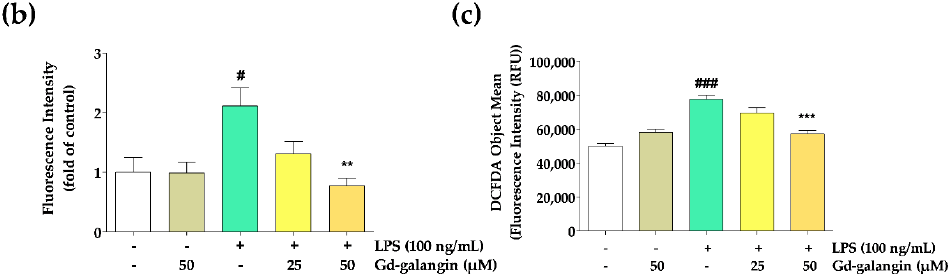
Figure 7. Reactive oxygen species (ROS)-scavenging effect of Gd-galangin on RAW 264.7 macrophage cells. Cellular ROS was determined by 2,7-dichlorofluoroscin diacetate (DCFDA) assay. ( a ) Images of RAW 264.7 cells captured with fluorescence microscope. Scale bar, 100 μ m. ( b ) The fluorescence intensity of ( a ) cellular images. ( c ) The fluorescence intensity measured using a microplate reader. (Data are shown as the mean ± SEM, t -test, n ≥ 3. # p < 0.05, ### p < 0.001 compared to control group; ** p < 0.01, *** p < 0.001 compared to LPS-stimulated group.).